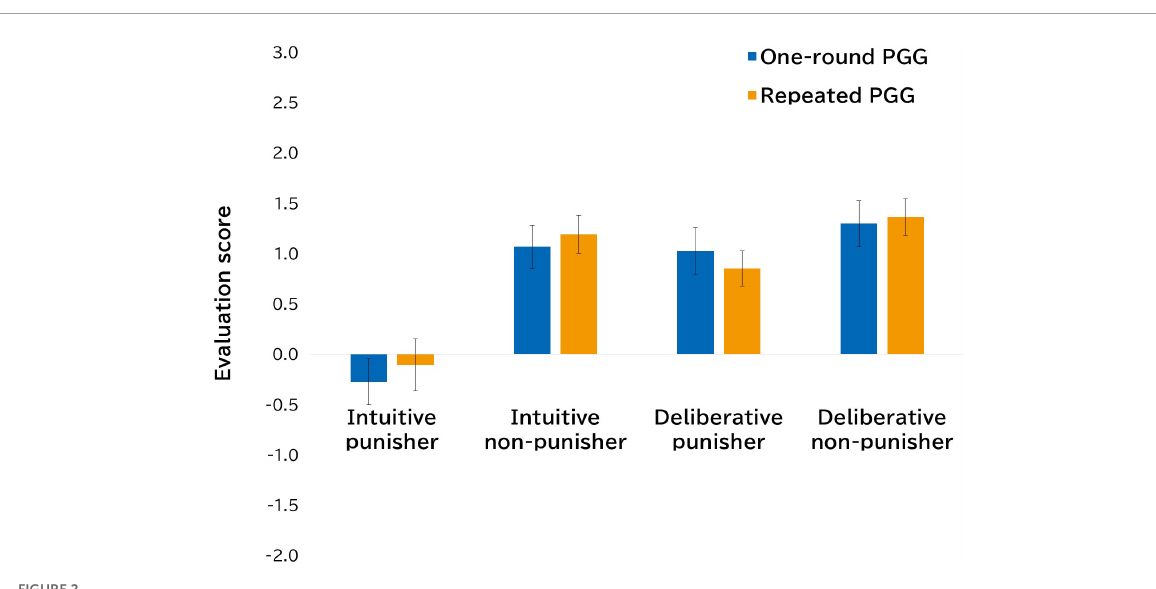
FIGURE2 Conditional differences in mean evaluation scores of intuitive (non-) punisher and deliberative (non-) punisher (Study